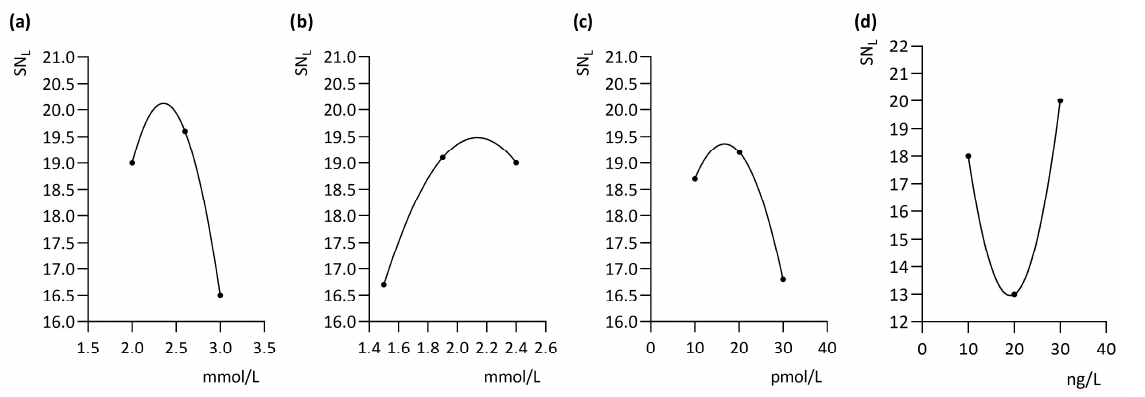
Figure 1. Amplification profiles for orthogonal array reactions performed for C . parapsilosis (F15_T1_IS_CP) and RP2 and 1247 primers. M—marker; lanes 1–9 obtained for different concen- trations of four components (MgCl 2 , dNTP, primers, DNA) prepared according to the orthogonal array.